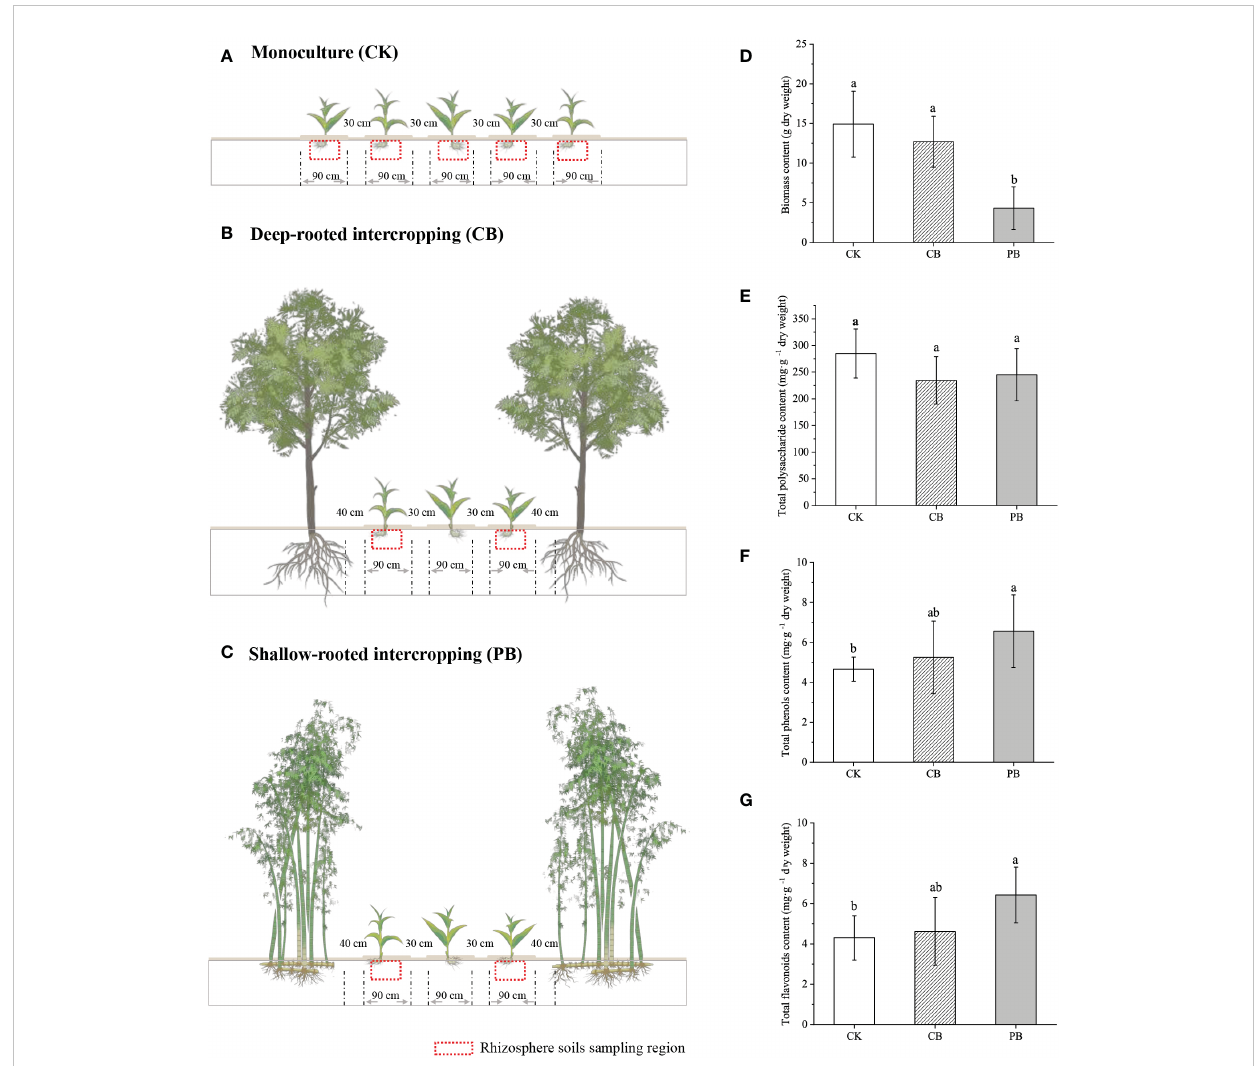
FIGURE 1 The schematic of B. striata cultivation modes: (A) monoculture, (B) C. paliurus intercropping with B. striata , (C) Moso bamboo intercropping with B. striata . The economic traits of B. striata variations among monoculture and intercropping modes: (D) biomass content, (E) total polysaccharide, (F) total phenol, and (G) total fl avonoids, different small letter in the same column indicates signi fi cant difference ( p < 0.05) among